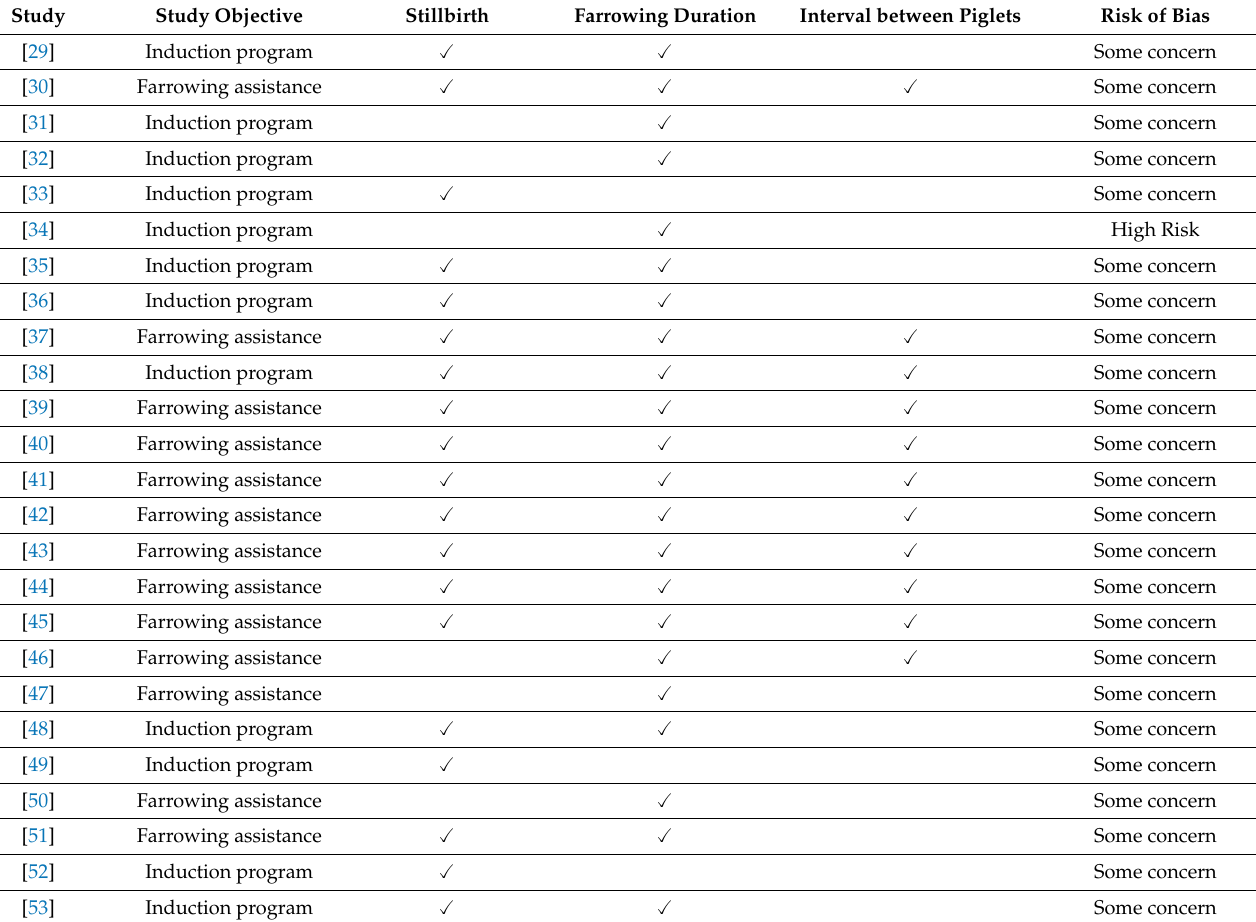
) indicates which studies were included in each (cid:8)